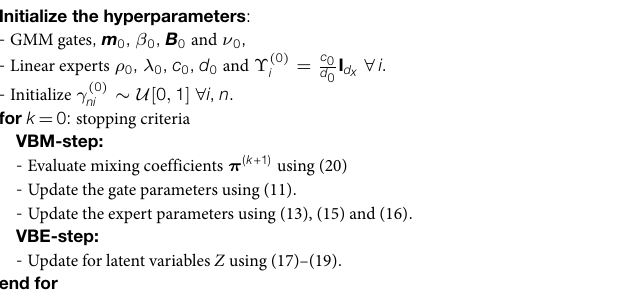
ALGORITHM 1 | Multivariate VBEM